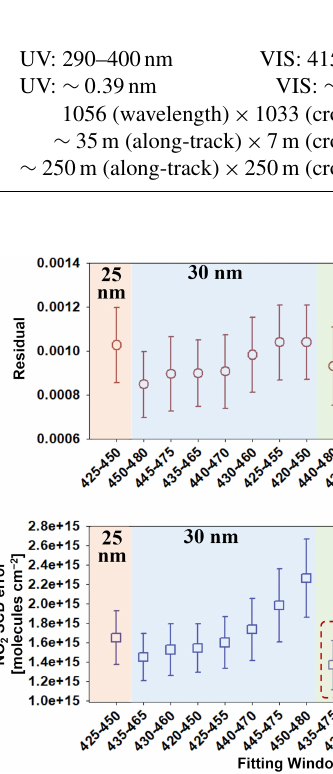
Figure 3. Residuals and NO 2 SCD errors of 17 spectral fitting win- dow candidates (17 May 2016, with an across-track number of 15).